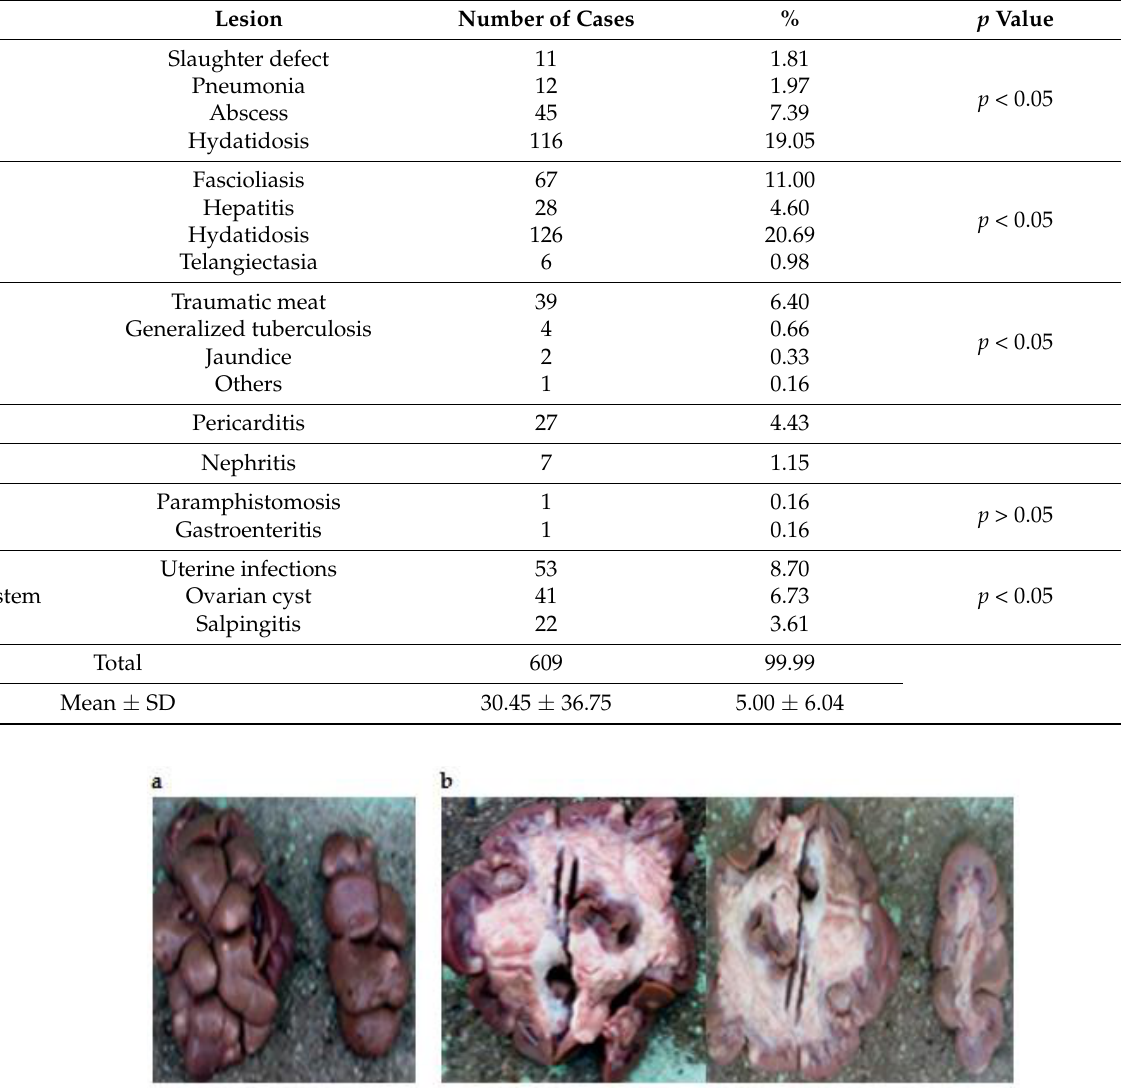
Figure 2. Interstitial nephritis. Figure 3. Paramphistomosis.